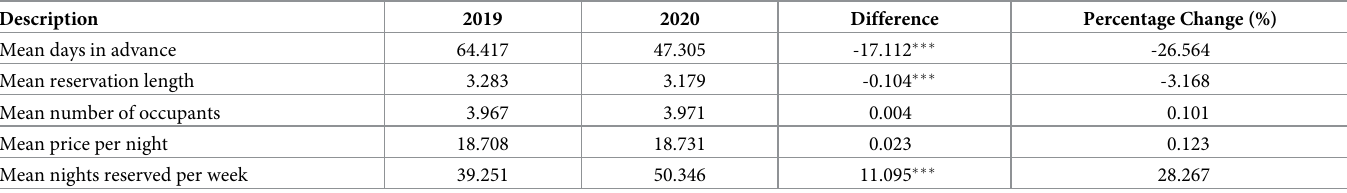
Table 1. Summary statistics for USFS campground reservations in 2019 and